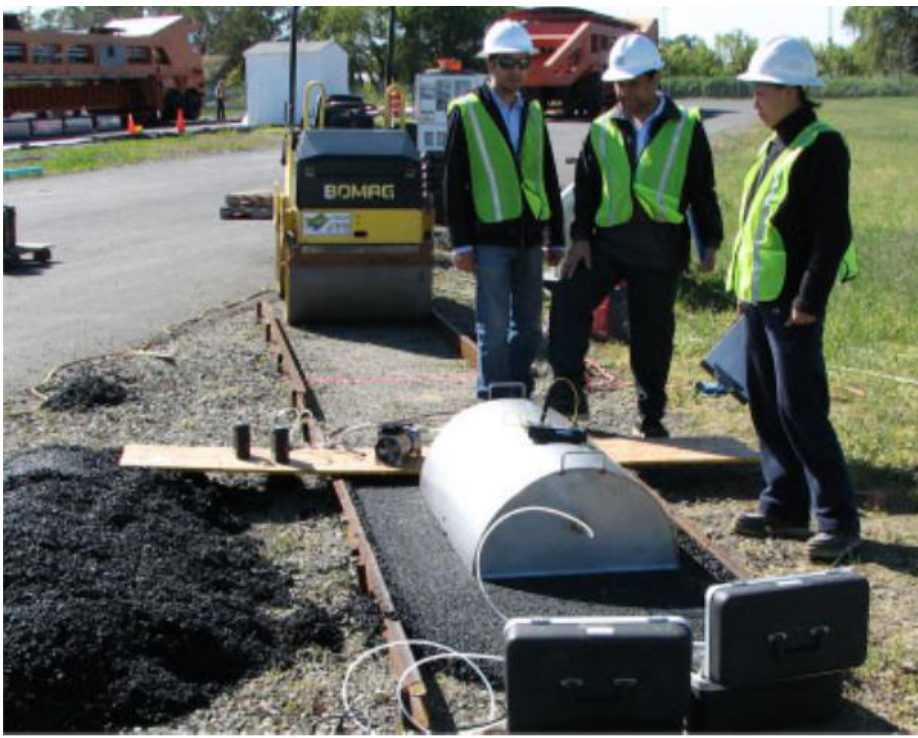
Figure 8. Measuring VOCs using the transportable flux chamber [67].